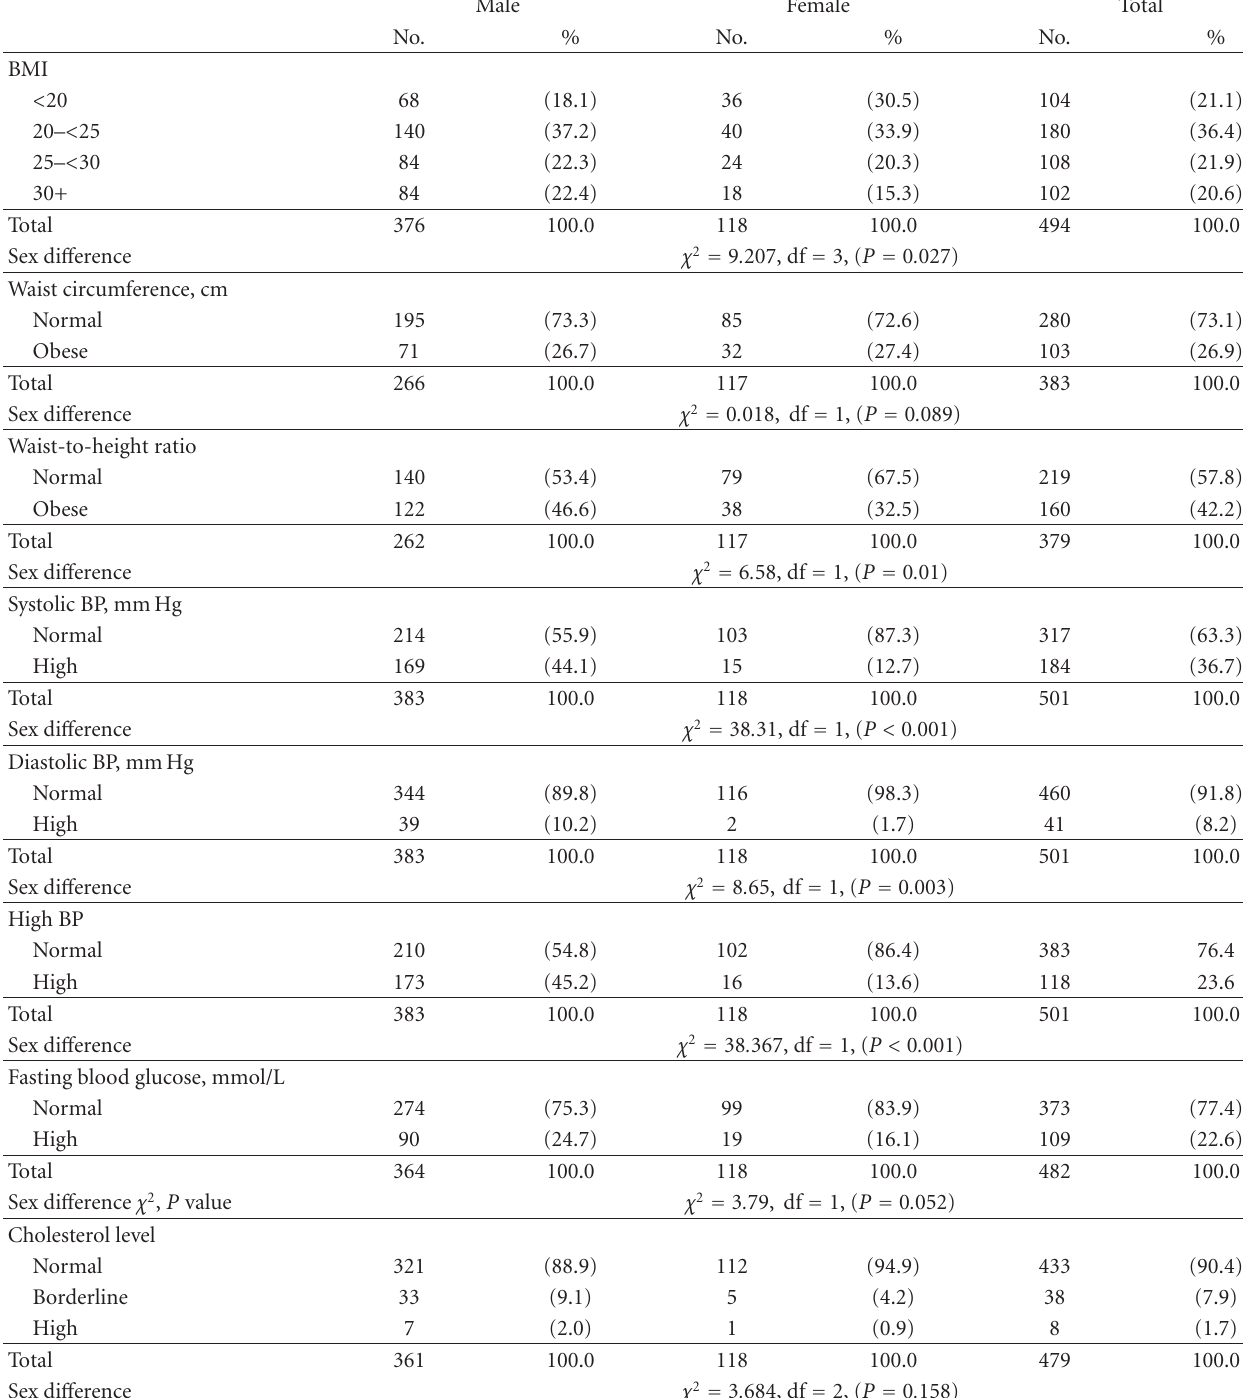
Table 1: Body composition and metabolic abnormalities among 501 Saudi college students aged 18–26